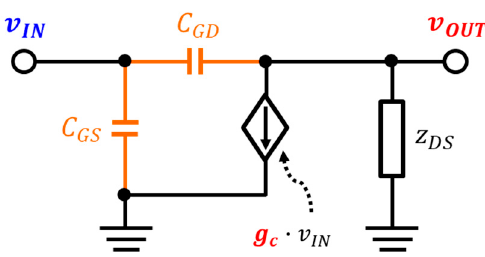
Figure 3. Schematic diagram of the proposed small-signal analysis for the plasmon detector core.